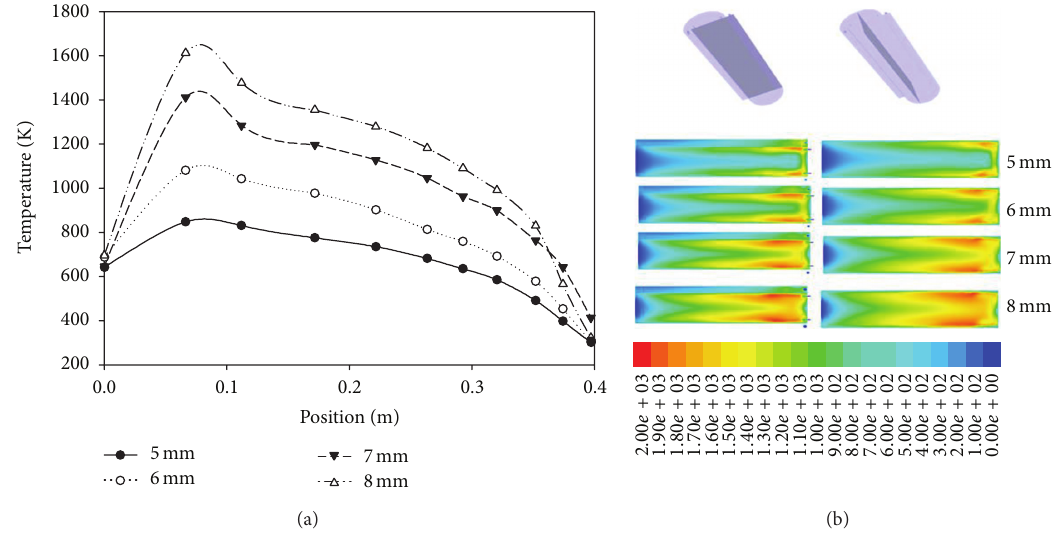
Figure 6: Effect of variations of air diameter on central temperature (K) profile: (a) line type and (b) contour type.